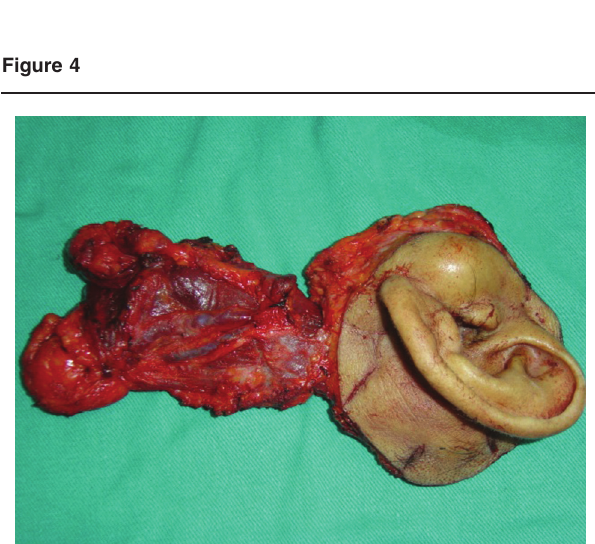
Anotherpatientaftertotalparotidectomyandpartialexcisionoftheauricle.